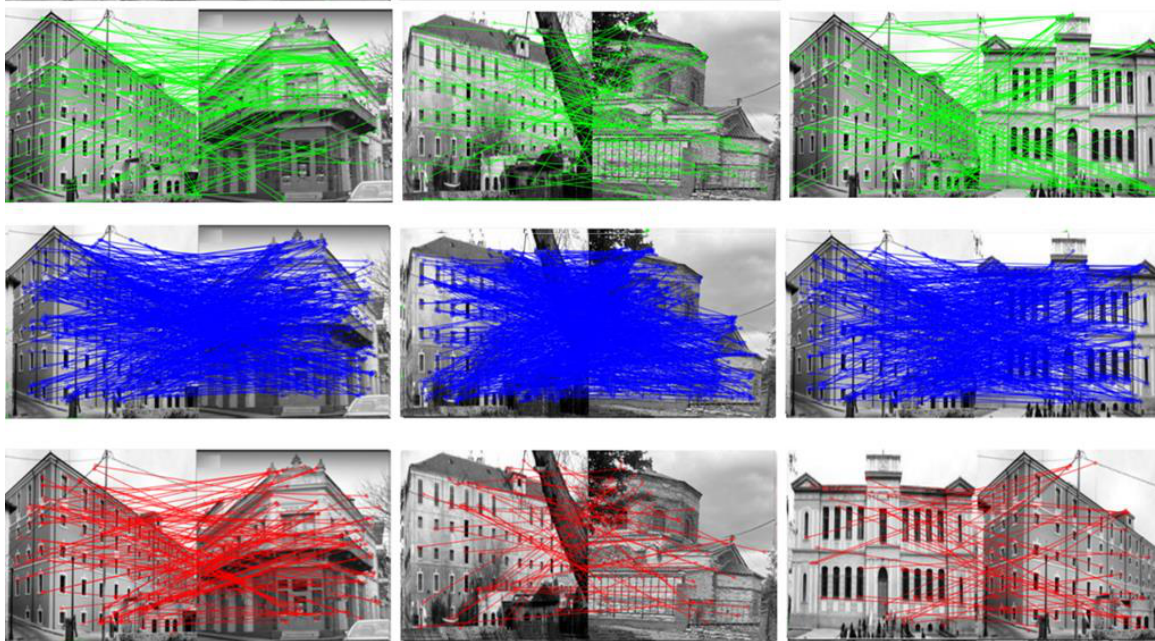
Figure 15. Feature matching of different buildings by SIFT, ORB, and BRISK algorithms with modified parameters.